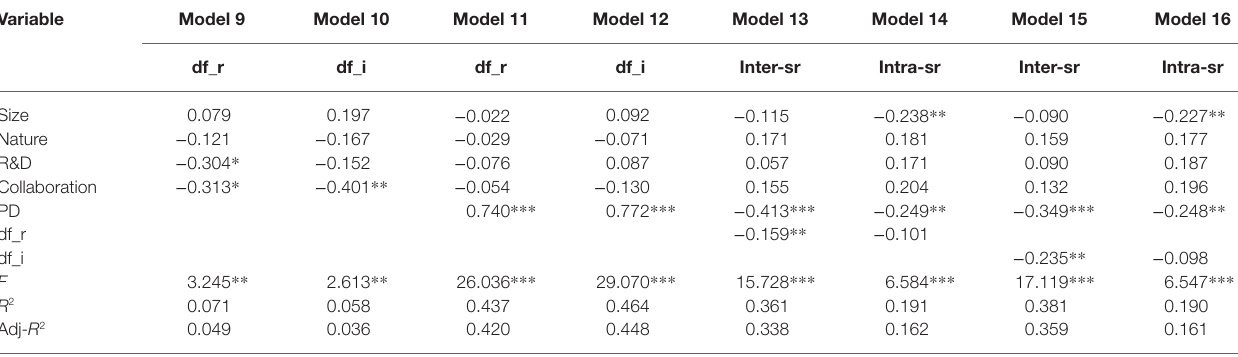
TABLE 5 | The mediating effects of divisive faultlines ( N = 174).